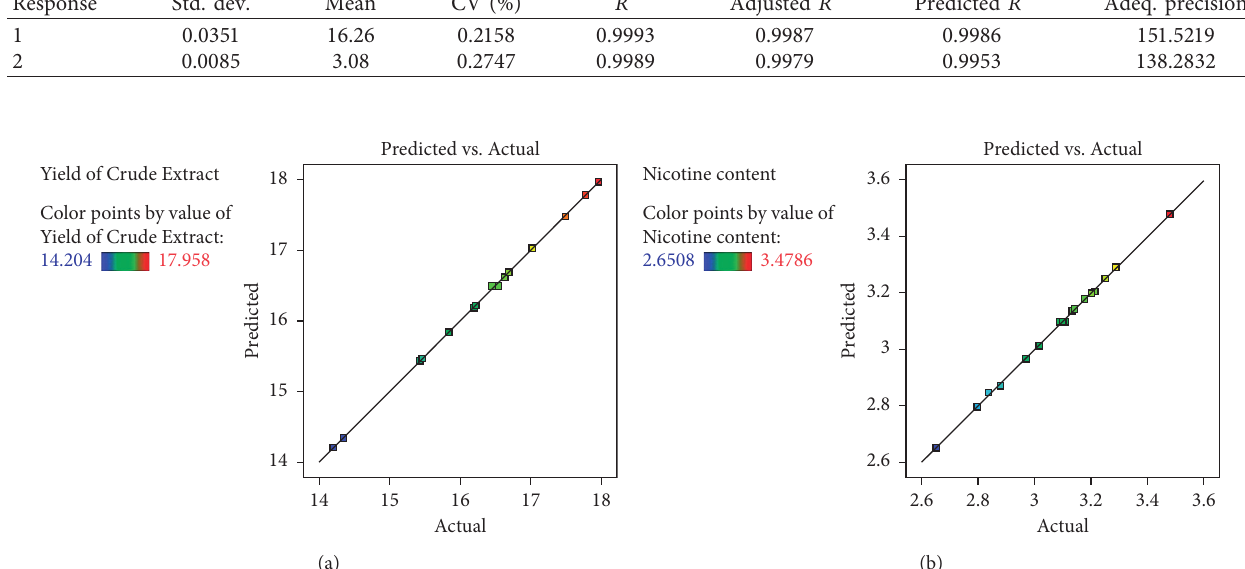
Figure 4: Actual value versus predicted value for (a) yield of crude extracts and (b) nicotine content.